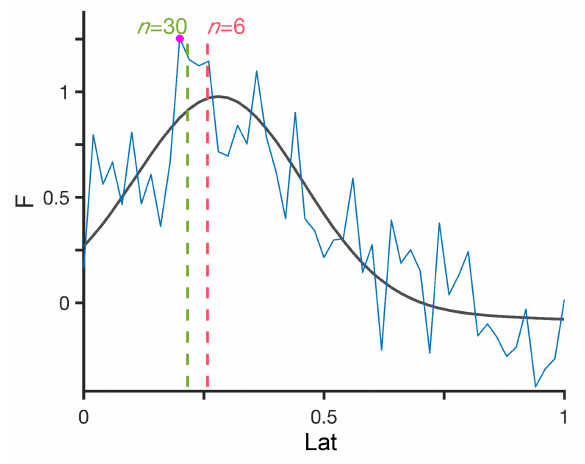
Figure 2. Example of the latitude of the maximum ( Ymax ) of a field F , calculated using TropD_Calculate_MaxLat(F,lat,n) . F is given as some skewed Gaussian function (black) with random noise (blue) on a discretized grid with a random resolution. The results for n=6 (red) and n=30 (green) are indicated by vertical lines. The absolute maximum is indicated by a dot (magenta).